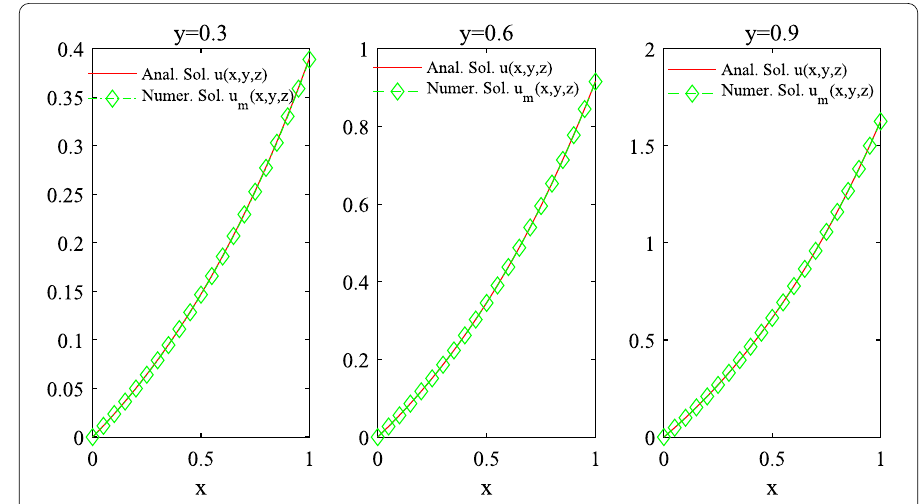
Figure 6 The numerical and analytical solution with m = 64 at y = 0.3,0.6,0.9 for Example 6.4